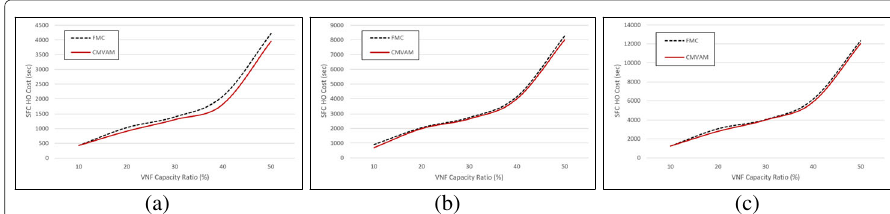
Fig. 5 The impacts of the VNF capacity ratio on the SFC HO costs. This is the results of the experiments about the impacts of the VNF capacity ratio on the SFC HO costs. The SFC HO cost meant the time that it took for all services to restore in the blockage, while the VNF capacity ratio meant the proportion of the storage of each VNF in the storage of total MEC server. In these experiments, we set the proportion of the UE of high mobility and the ordinary UE as 4:1, 1:1, and 1:4 in each cell